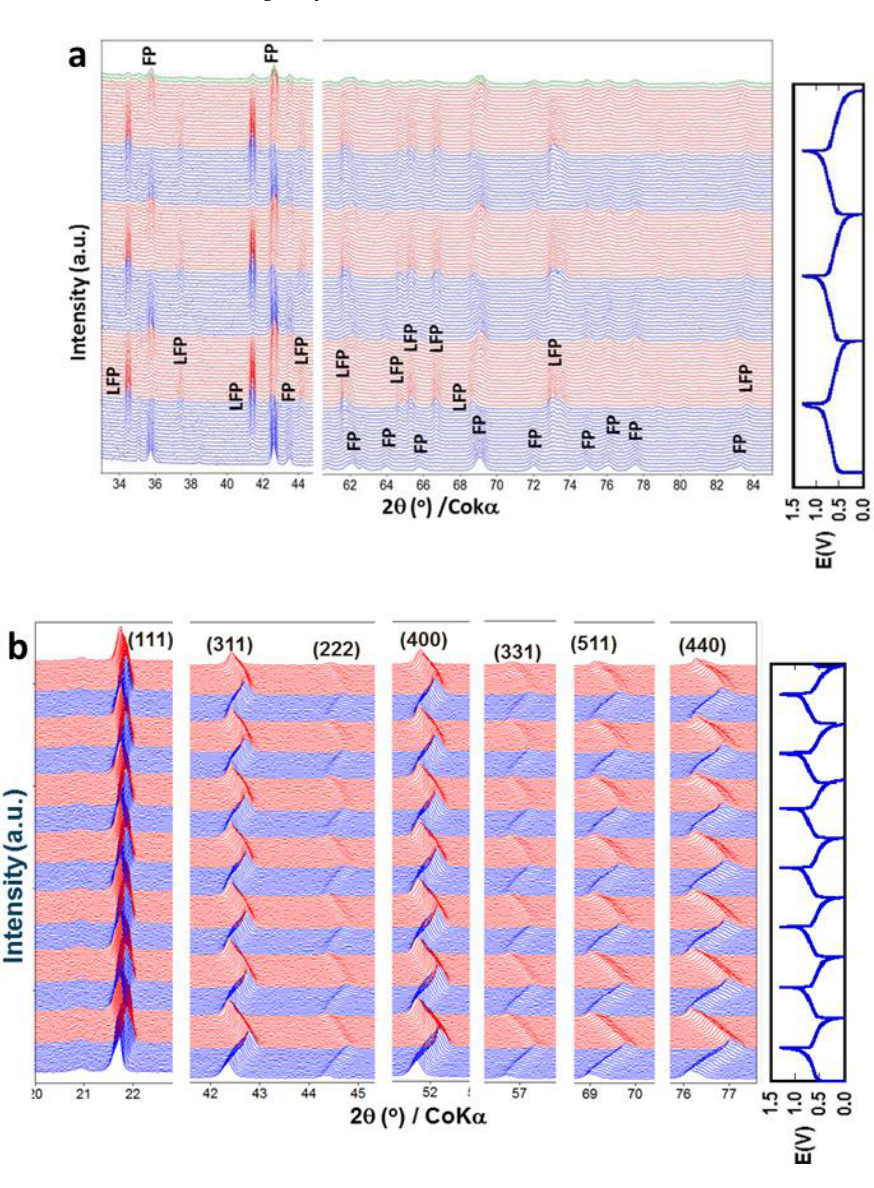
Figure 16. Evolution of XRD patterns of ( a ) olivine FePO 4 and ( b ) LiMn 2 O 4 upon cycling [194], with permission from ACS.